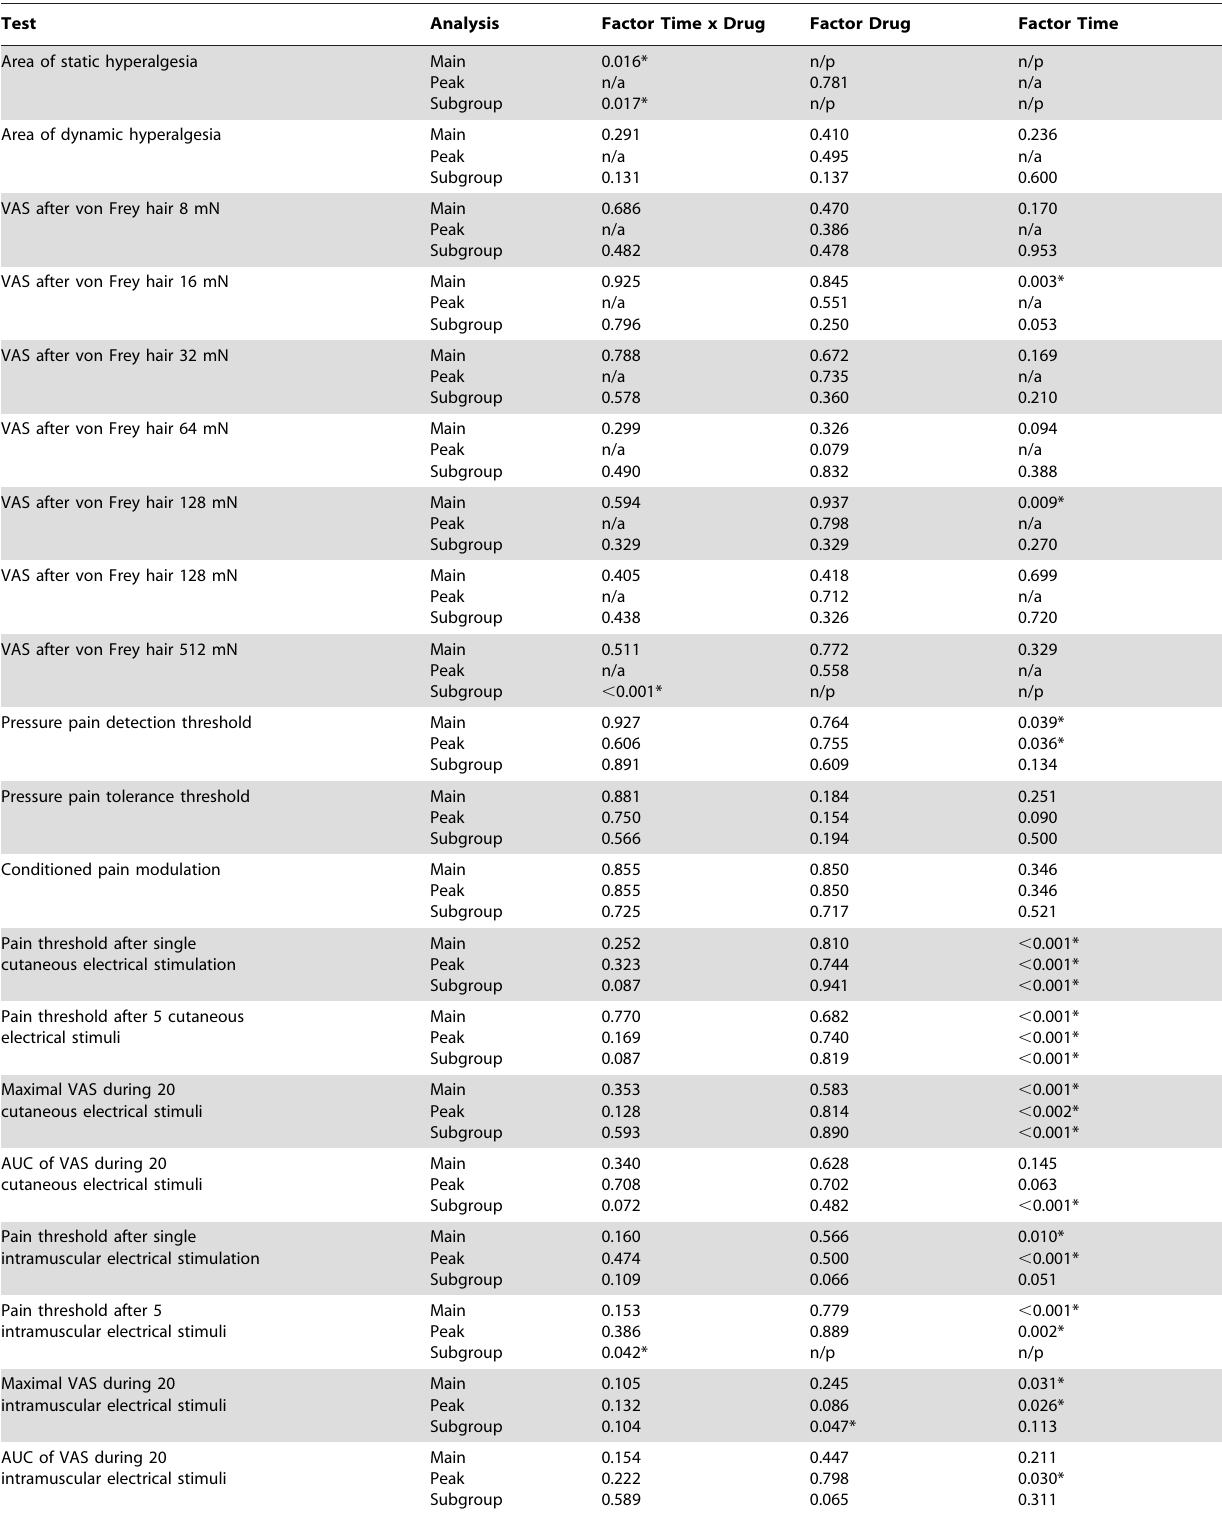
Table 3. Results of the ANOVA analyses on all the